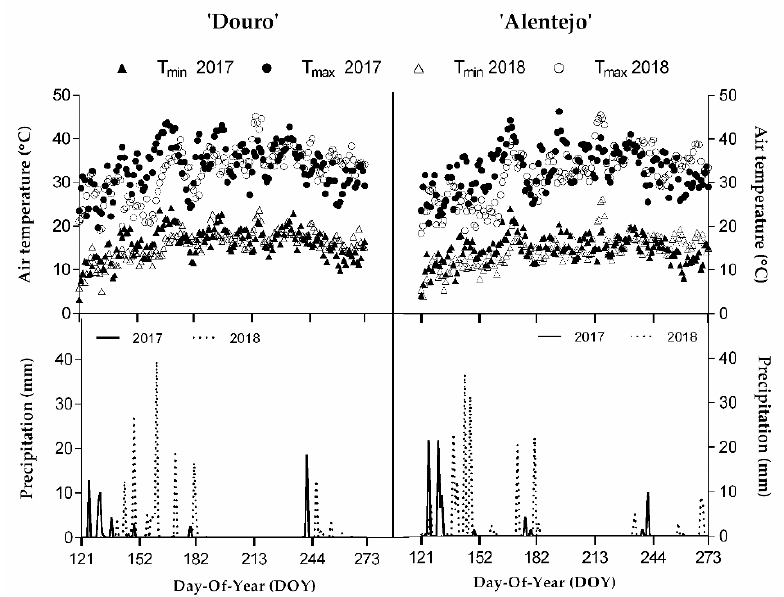
Figure 1. Daily minimum and maximum air temperature (°C), and precipitation (mm) of 2017 and 2018 growing seasons at both Douro and Alentejo sites.